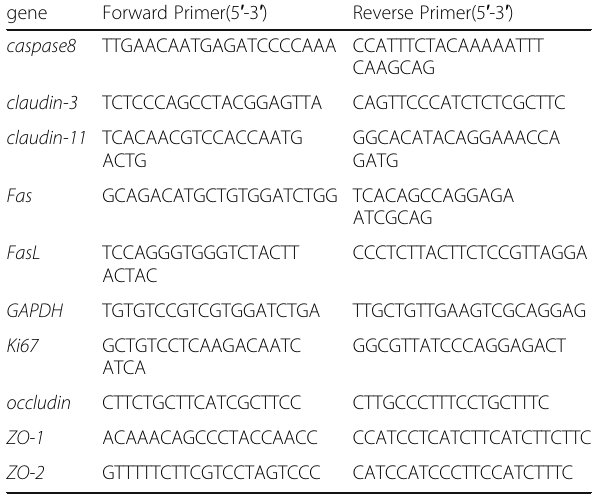
Table 2 Primers used for real-time RT-PCR gene